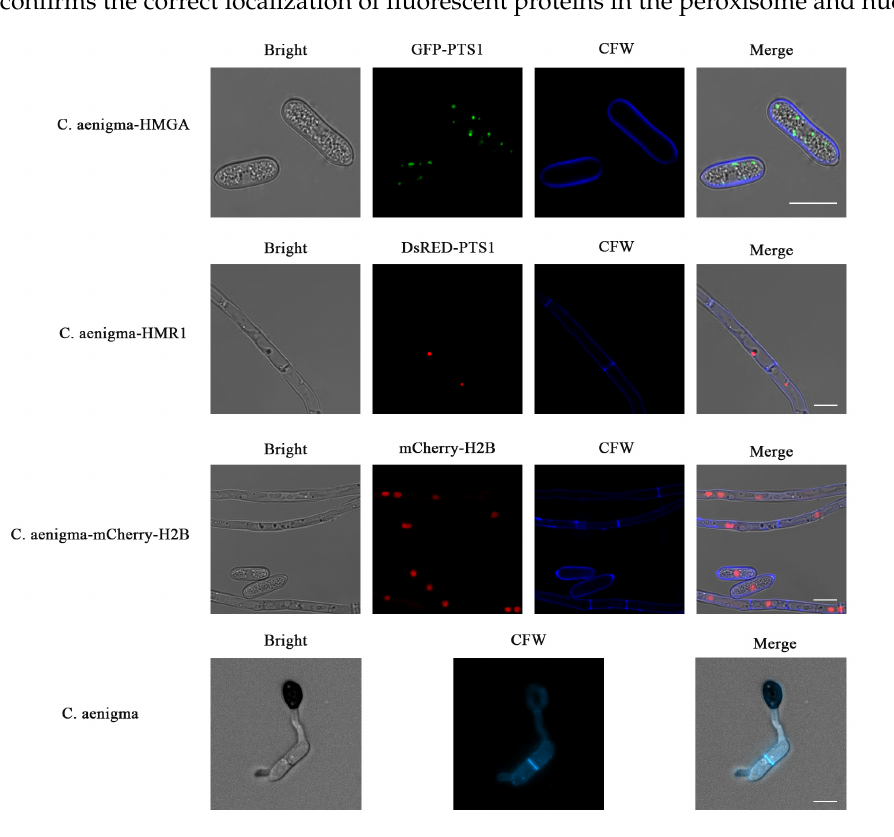
Figure 7. The calcofluor white (CFW) staining of the fluorescent transformants, Bars = 10 µ m. The CA-HMGA, CA-HMR1, and CA-mCherry-H2B transformants and the wild type of C. aenigma were stained with CFW and detected under the confocal microscope. The cell walls stained by the CFW emi tt ed the blue fl uorescence, well co-existed with the green fl uorescence of GFP-PTS1 and the red fl uorescence of DsRED-PTS1 and mCherry-H2B.